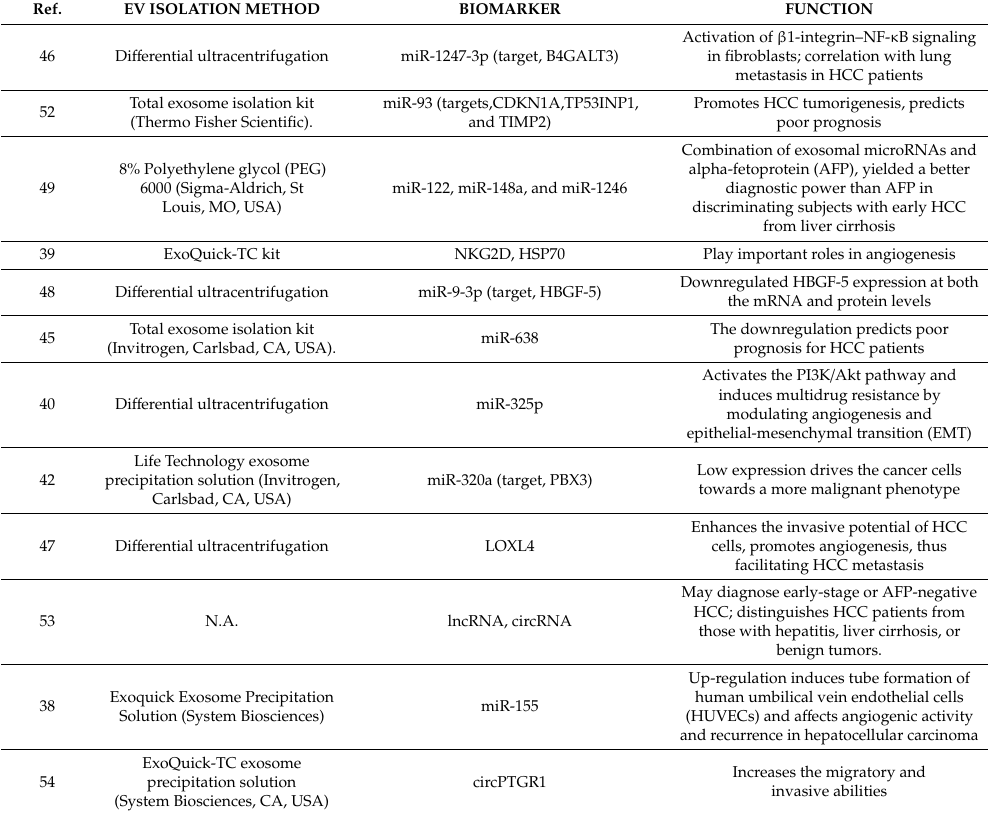
Table 1. Summary of most recent isolation techniques, biomarkers, and functions of extracellular vesicles (EVs) in hepatocellular carcinoma (HCC).